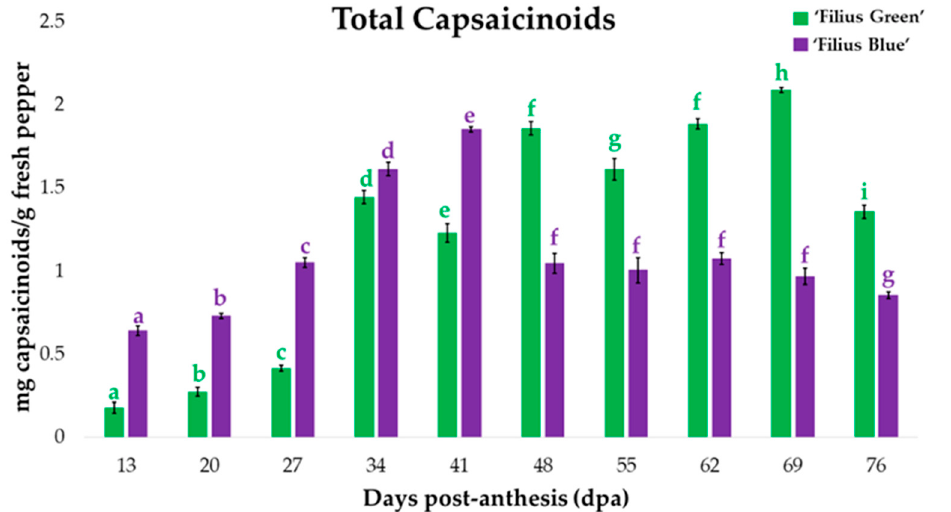
Figure 2. Total capsaicinoid concentration (mg g − 1 fresh weight (FW)) during fruit ripening ( n = 2). The same letter assigned to each variety indicates that there was no significant variation in capsaicinoids content according to Tuckey’s test, that is, both values have a p -value > 0.05. Letter colors correspond to their respective variety, i.e., green for ‘Filius Green’ and purple for ‘Filius Blue’.